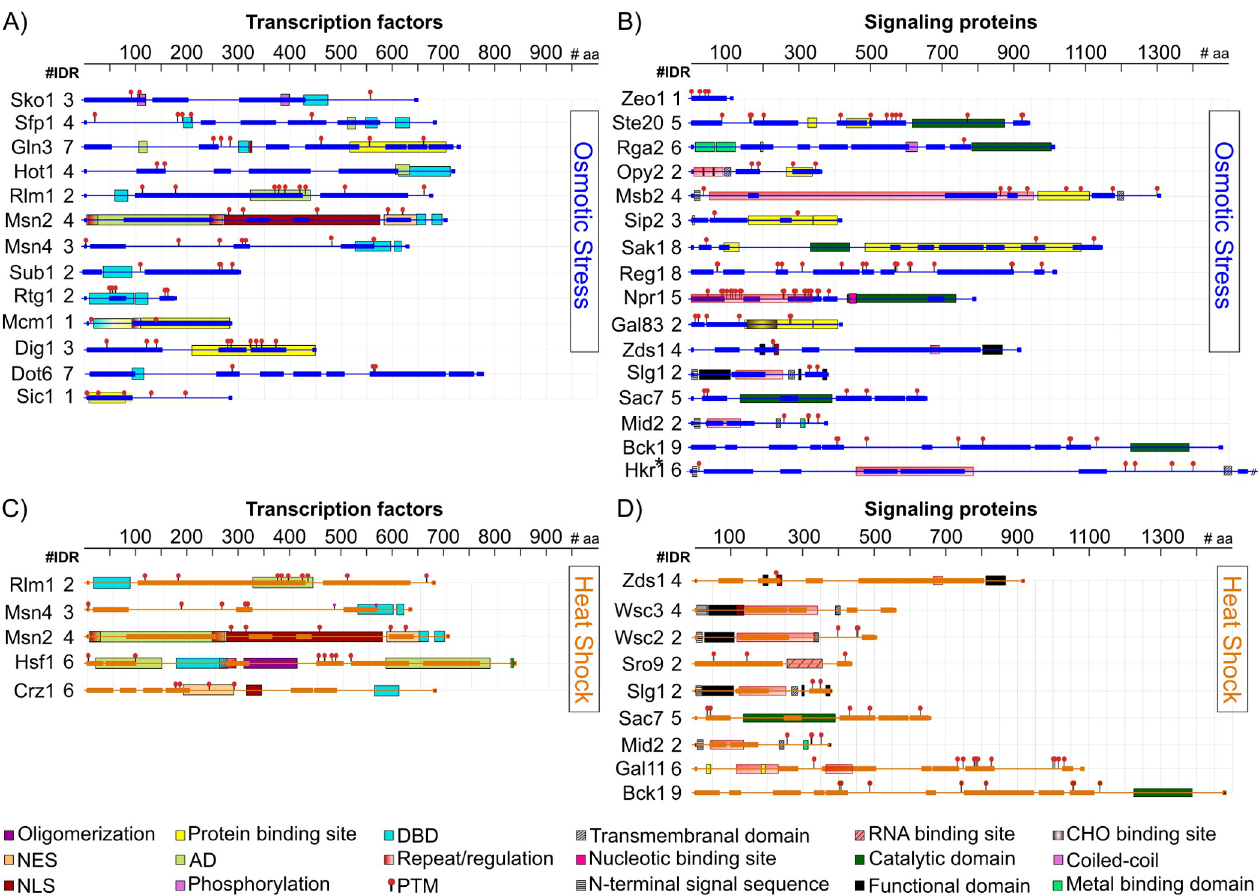
Fig 4. IDRs and functional domains in IDTFs and in signaling proteins involved in osmotic and heat shock response signaling pathways. (A and B) osmotic stress and (C and D) heat shock. The functional domains shown in this figure are those supported by experimental evidence. NES: Nuclear Export Sequence; NLS: Nuclear Localization Sequence; TAD: Transcription Activation Domain; DBD: DNA Binding Domain; PTM: Post-Translational Modification; CHO: Carbohydrate Binding Site. IDRs are showed as bars in osmotic stress (blue) and heat shock (orange). The rulers above each protein representation schemes indicate the number of amino acid